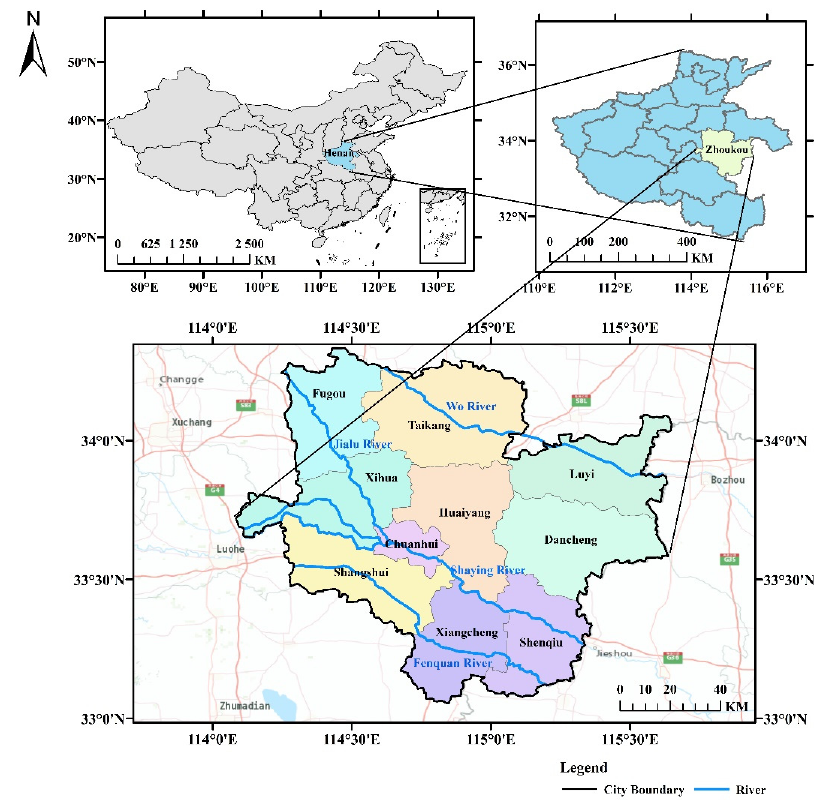
Figure 1. Zhoukou City location map.